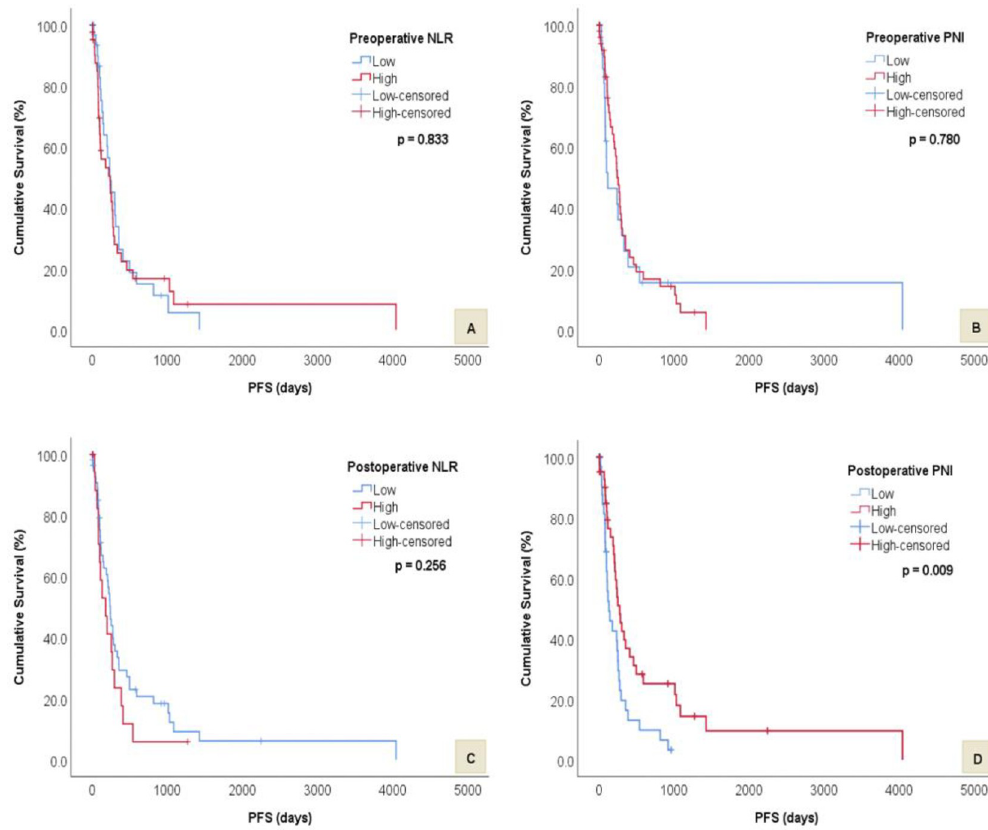
Fig 1. Kaplan-Meier survival curves and log rank tests showing differences in PFS between low and high preoperative and postoperative NLR and PNI groups. A) Difference in PFS between low and high preoperative NLR. B) Difference in PFS between low and high preoperative PNI. C) Difference in PFS between low and high postoperative NLR. D) Difference in PFS between low and high postoperative PNI.